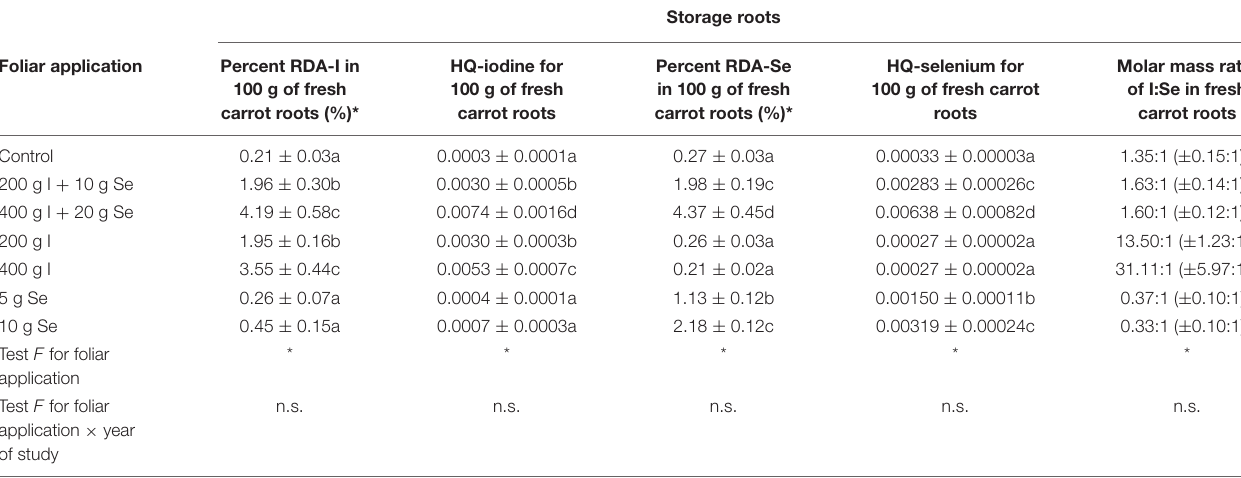
FIGURE 1 | Total iodine, iodide ion (I - ) (A,B) , and total selenium (C,D) contents in carrot leaves (A,C) and storage roots (B,D) , depending on the foliar application of both elements. Application 200 g I + 10 g Se · ha − 1 and 400 g I + 20 g Se · ha − 1 by “I + Se” fertilizer, application of 200 g and 400 I · ha − 1 by “Solo iodine” fertilizer, and application 5 g and 10 g Se · ha − 1 by “Solo selenium” · fertilizer. The results of the test F for “foliar application” for all qualitative features in panels (A–D) were statistically significant. The results of the test F for “foliar application × year of study” for all qualitative features in panels (A–D) were not statistically significant. Means followed by the same letters are not significantly different for p < 0.05; bars indicate standard error ( n = 8). Average for the years 2019–2020. TABLE 5 | Percentage of Recommended Daily Allowance (RDA) for iodine (RDA-I) and selenium (RDA-Se) in 100-g portion of fresh carrot roots, I:Se molar ratio in fresh carrot roots, and hazard quotient (HQ) for intake of I and Se through the consumption of 100 g of fresh carrot roots by adults (70-kg body weight), depending on the foliar application of iodine and